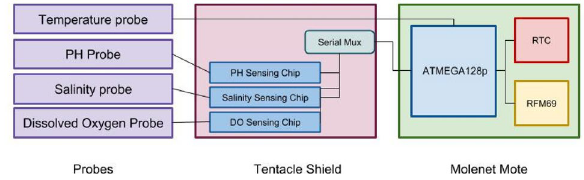
Fig. 3 Architecture of